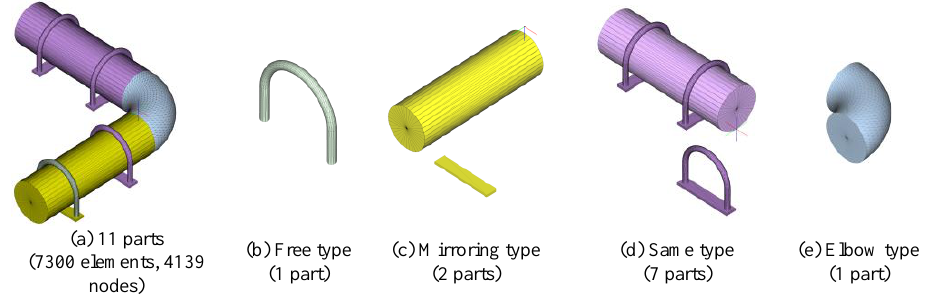
Figure 17. Data size minimization for hook-up spool.